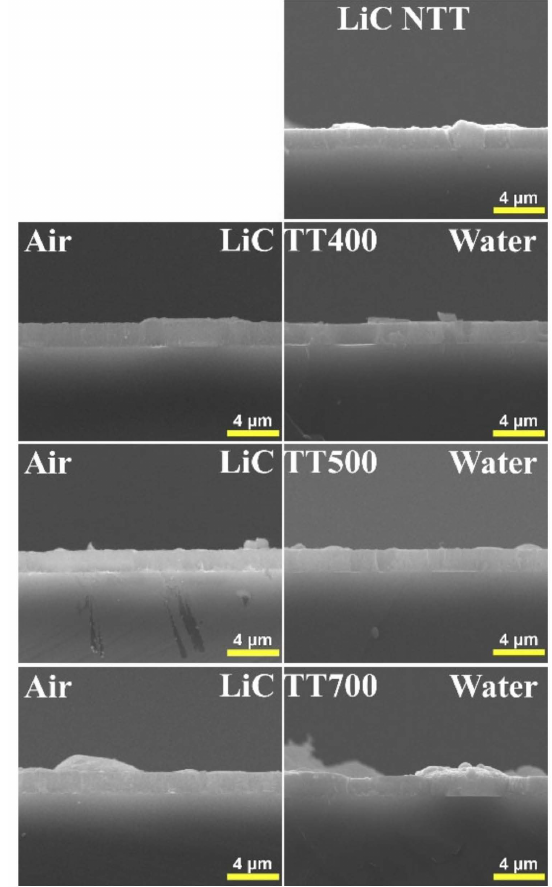
Figure 6. Cross-view SEM micrographs of control Ti, NTT LiC samples and of those subjected to post-deposition thermal treatments (at different temperatures), in air and water-vapor ambient, synthesized onto Si